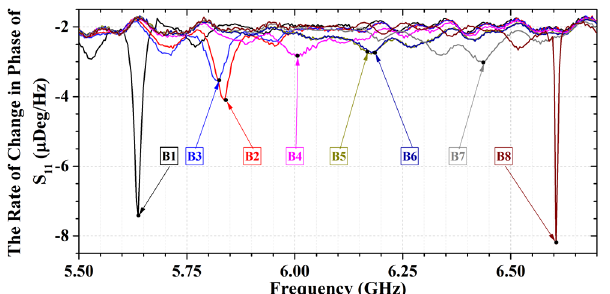
Figure. 10. S 11 change-rate versus frequency. The marked points are the measured phase at the resonant frequency of their corresponding